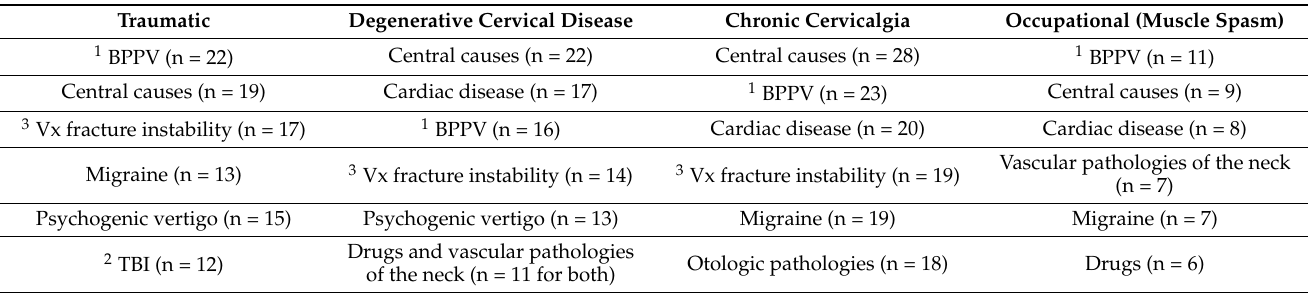
Table 2. Occurrences of differential diagnoses in articles mentioning different subpopulations of PCGD.